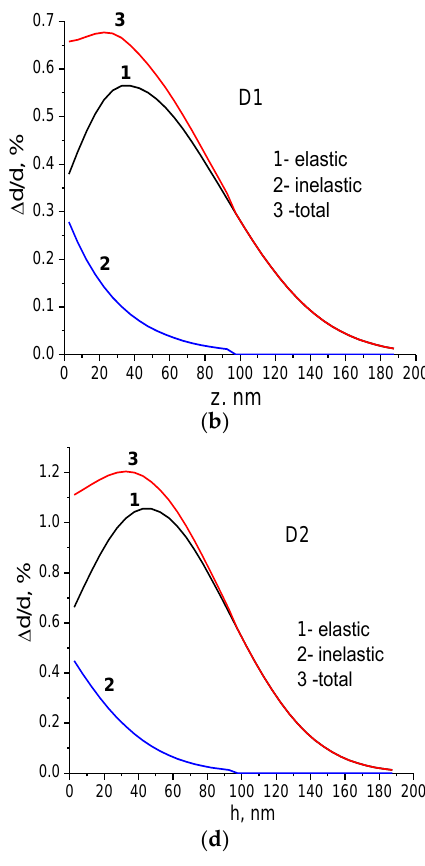
Figure 4. Experimental (circles) and calculated (solid lines) rocking curves ((444) reflection) of YIG/GGG heterostructures implanted with Ne + ions ( E = 82 keV) with doses of 1 × 10 14 cm −2 ( a ) and 2 × 10 14 cm −2 ( c ), as well as the corresponding strain profiles ( b ) and ( d ), respectively.